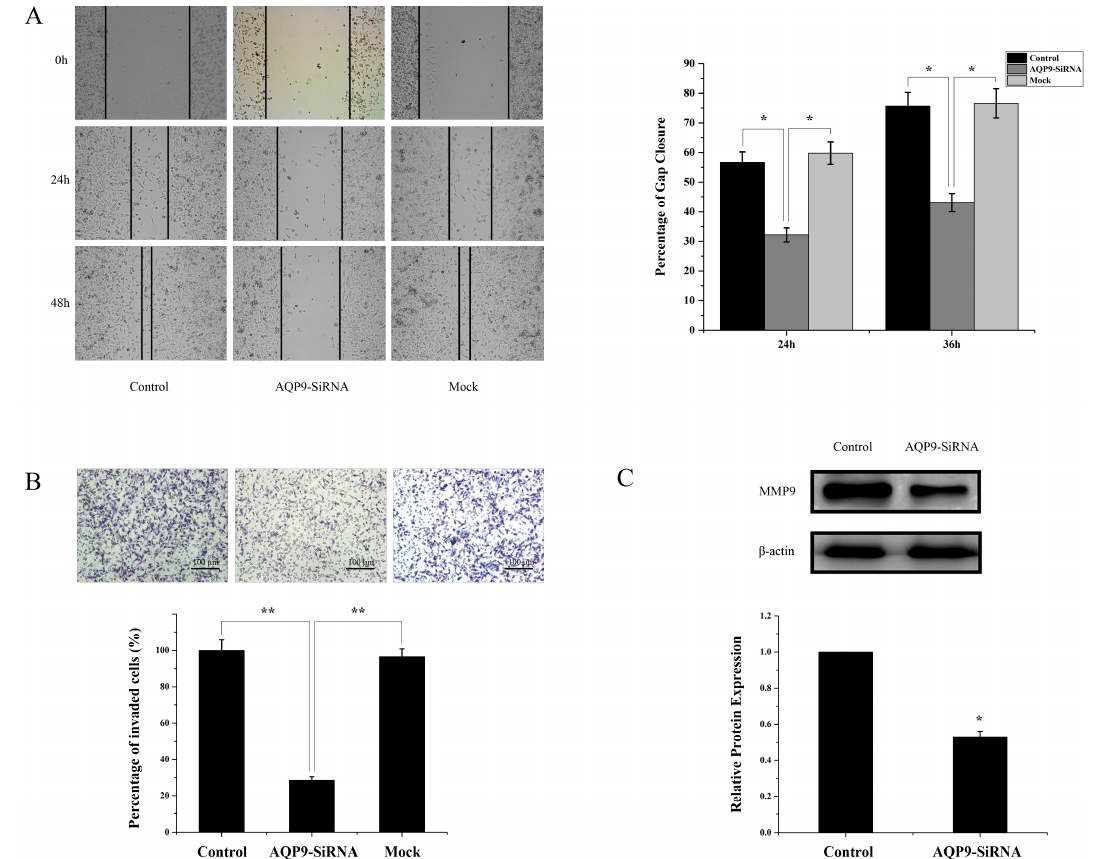
Figure 6. ( A ) Confluent cell monolayers were wounded with a pipette tip. Representative images were captured at 0 h, 24 h, and 36 h. The wound closure was quantified and normalized to that of control cells ( p < 0.05); Cell invasion was analyzed in Matrigel-coated transwell chambers. Representative images were shown in ( B ); invaded cells were counted in four selected fields (total space is 2 mm 2 ) ( p < 0.05 as compared with control); the total number of invaded cells from the control group set as 100%; ( C ) MMP9 protein expression was examined by Western blot. The mean of MMP9 protein/ β -actin expression in PC-3 cells set as 1.0. Control: wild-type cells; AQP9-siRNA: cells transfected with AQP9 specific small interfering RNA; Mock: cells only treated with Lipofectamine 2000. Data were based on three independent experiments, and shown as mean ± SD. * p < 0.05; ** p < 0.01, Bars, 100 µm.